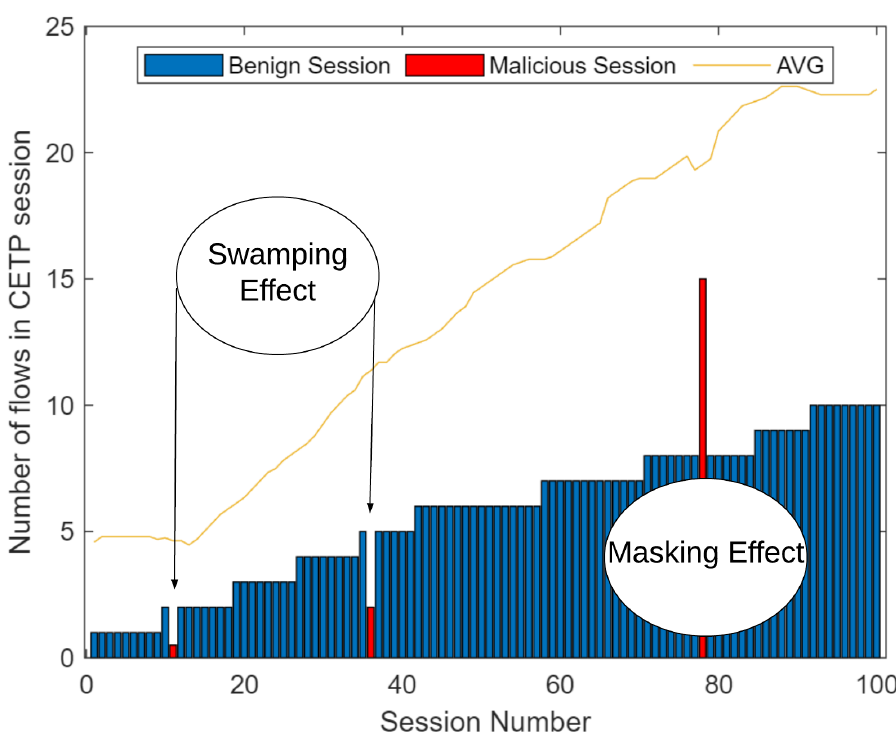
Figure 9. Masking and swamping